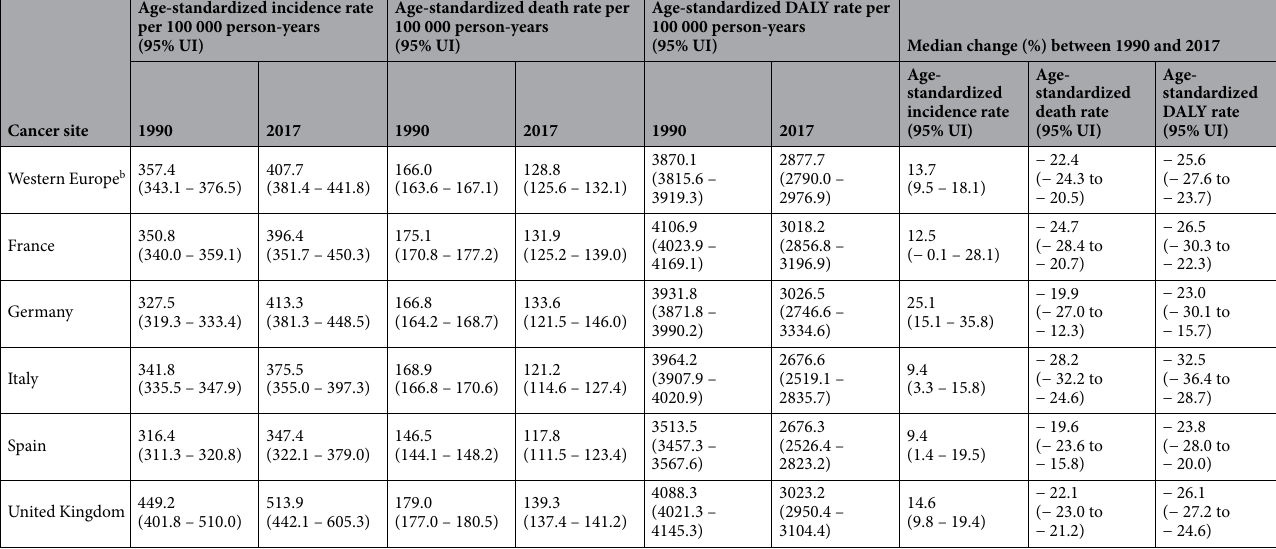
Table 2. Age-standardized incidence, death, and disability adjusted life years (DALY) rates for all cancer a in Western Europe and selected countries of Western Europe in 1990 and 2017, and corresponding percent changes. UI: uncertainty intervals. a Includes malignant neoplasms (International Classification of Diseases 10 [ICD-10] codes C00-C96, excluding Kaposi sarcoma, ICD-10 C46), benign/in situ neoplasms (ICD-10 D00- D49), and other malignant neoplasms (ICD-10 codes C17, C30-C31, C37, C38, C40-C41, C47-C49, C4A, C51- C52, C57-C58, C60, C63, C66, C68, C69, C74-C75). b Includes Andorra, Austria, Belgium, Cyprus,